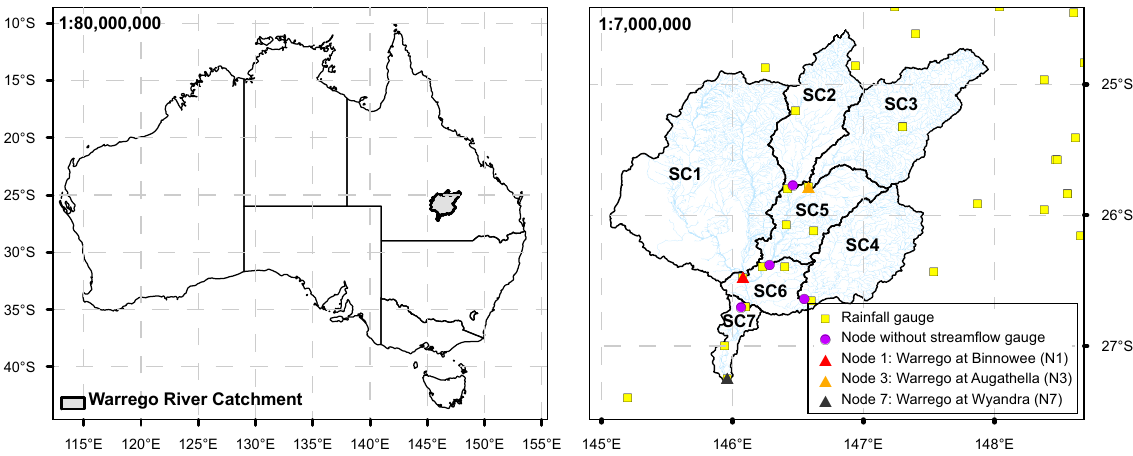
Figure 1. The Warrego River basin located in Queensland, Australia (left panel). A close-up of the area is presented in the right panel. The lumped PDM scheme is set up over the entire catchment, while the semi-distributed scheme divides the total catchment in seven sub- catchments (SC1–SC7).